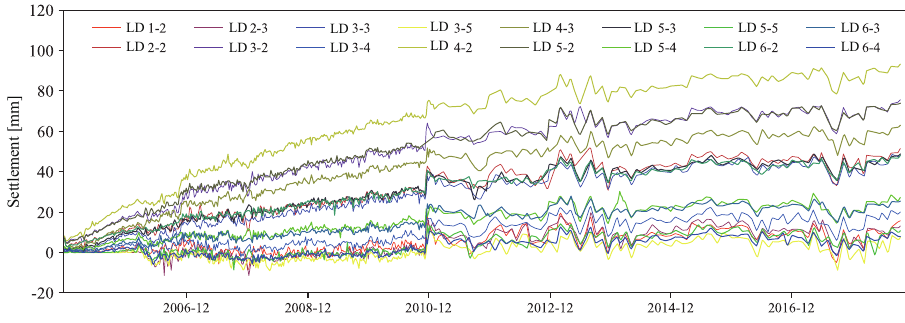
Figure 6. Settlement data series of selected monitoring points.